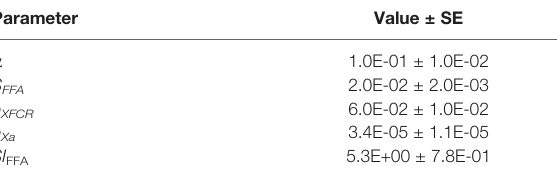
TABLE 2 | Mean ± SE parameter estimates (n=25).